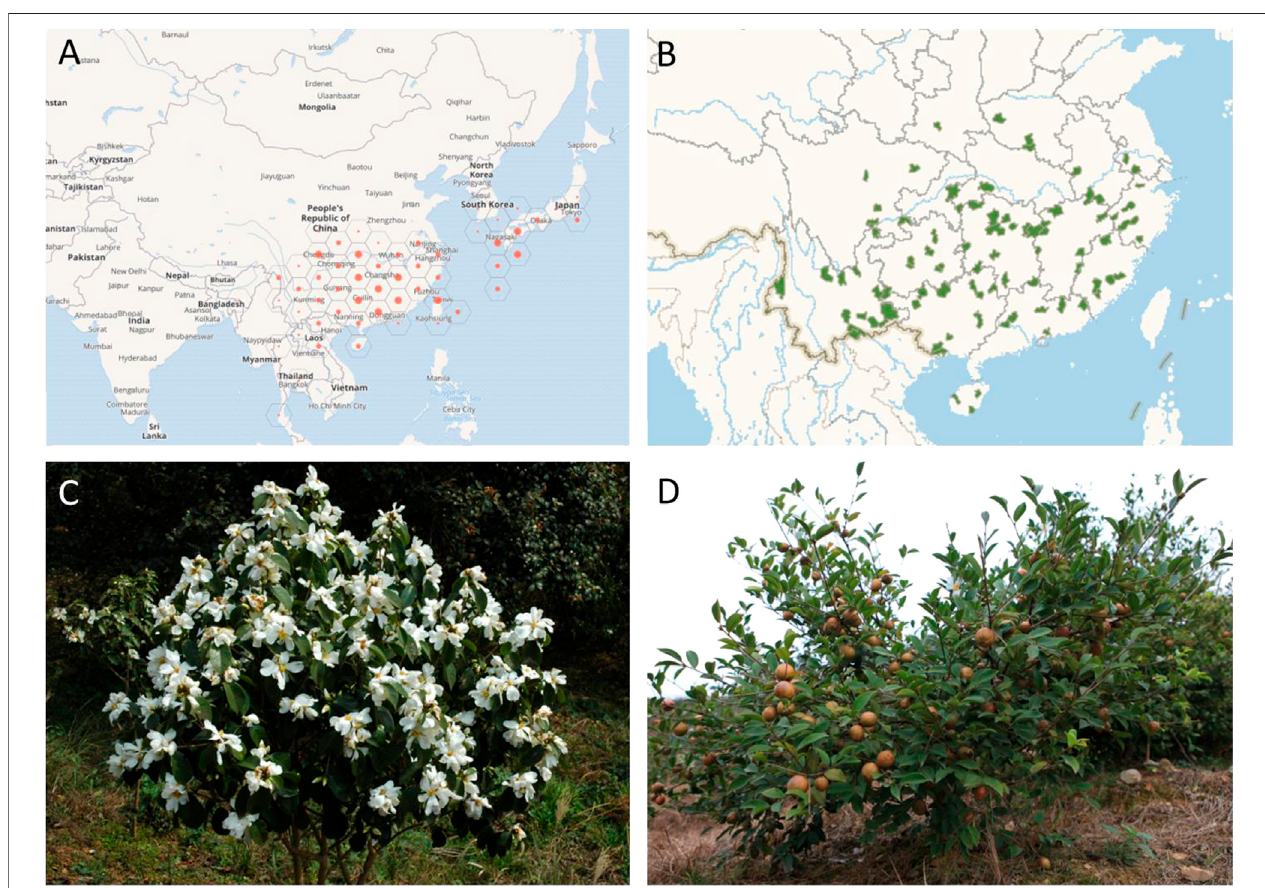
FIGURE 1 | Distribution (A,B) of C. oleifera and images of the fl owers and fruits (C,D) of C. oleifera